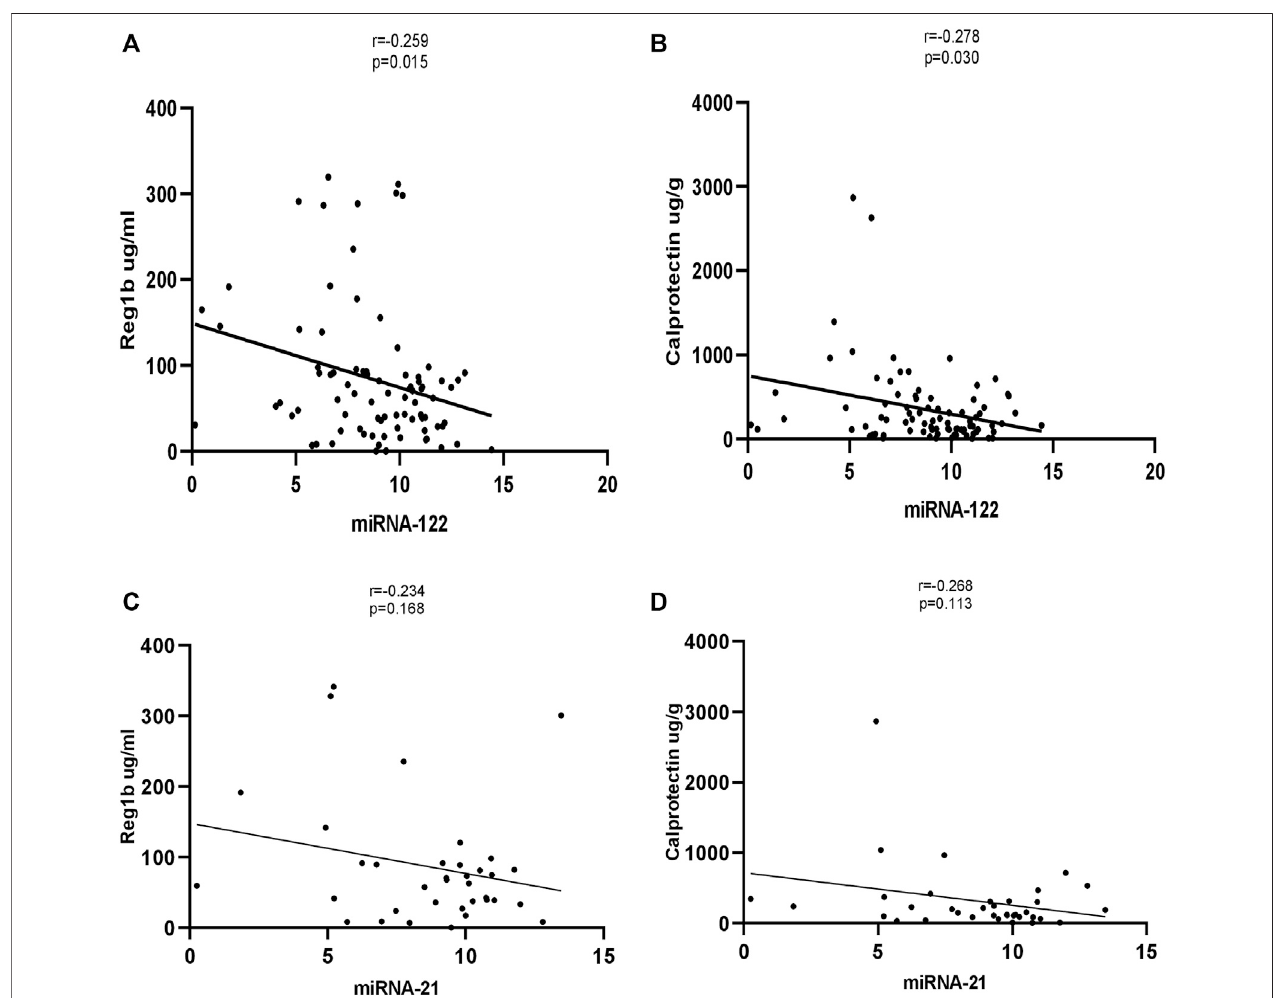
FIGURE 4 | Correlation of expression levels of miRNA-122 and miRNA-21 values with fecal biomarkers (with Reg1b and Calprotectin). The X -axis indicates the relative expression of miR-122, while the Y -axis denotes fecal biomarkers. We performed Pearson ’ s correlation test for statistical evaluation which showed a signi fi cant association between miRNA-122 (A, B) and fecal biomarkers, but no signi fi cant association was seen between miRNA-21 and fecal biomarkers (C, D) .